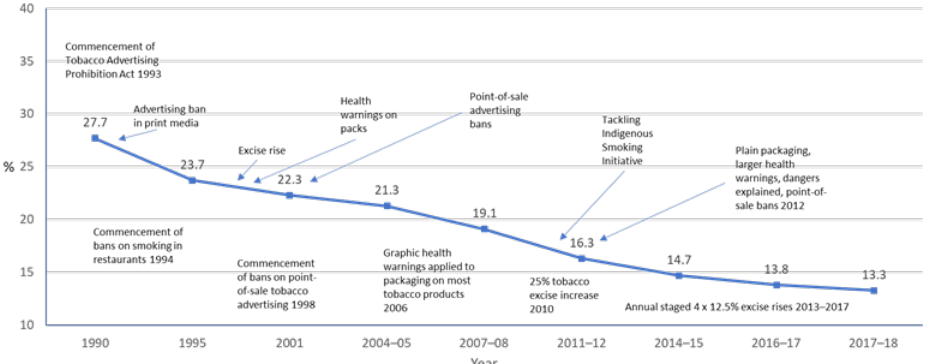
Figure 1: Prevalence of daily smoking for Australians 14 years or older and key tobacco control measures implemented in Australia since 1990 (age-standardised to the 2001 Australian population). (Source: Adapted from ABS 2015 and